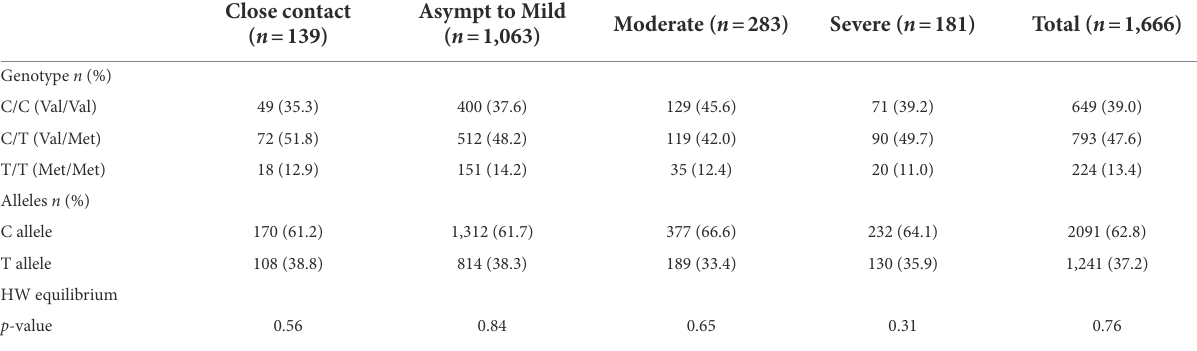
TABLE 2 Contingency tables for TMPRSS2 genotype in the noninfected close-contact group and the infected groups classified by severity of COVID-19. Close contact Asympt to Mild Moderate ( n = ( n = 139) ( n = 1,063)